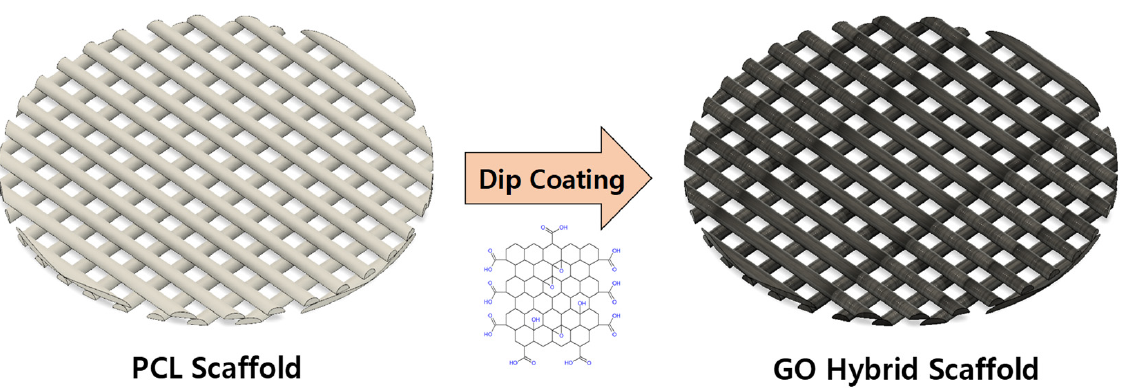
Figure 1. Schematic diagram of scaffold fabrication.